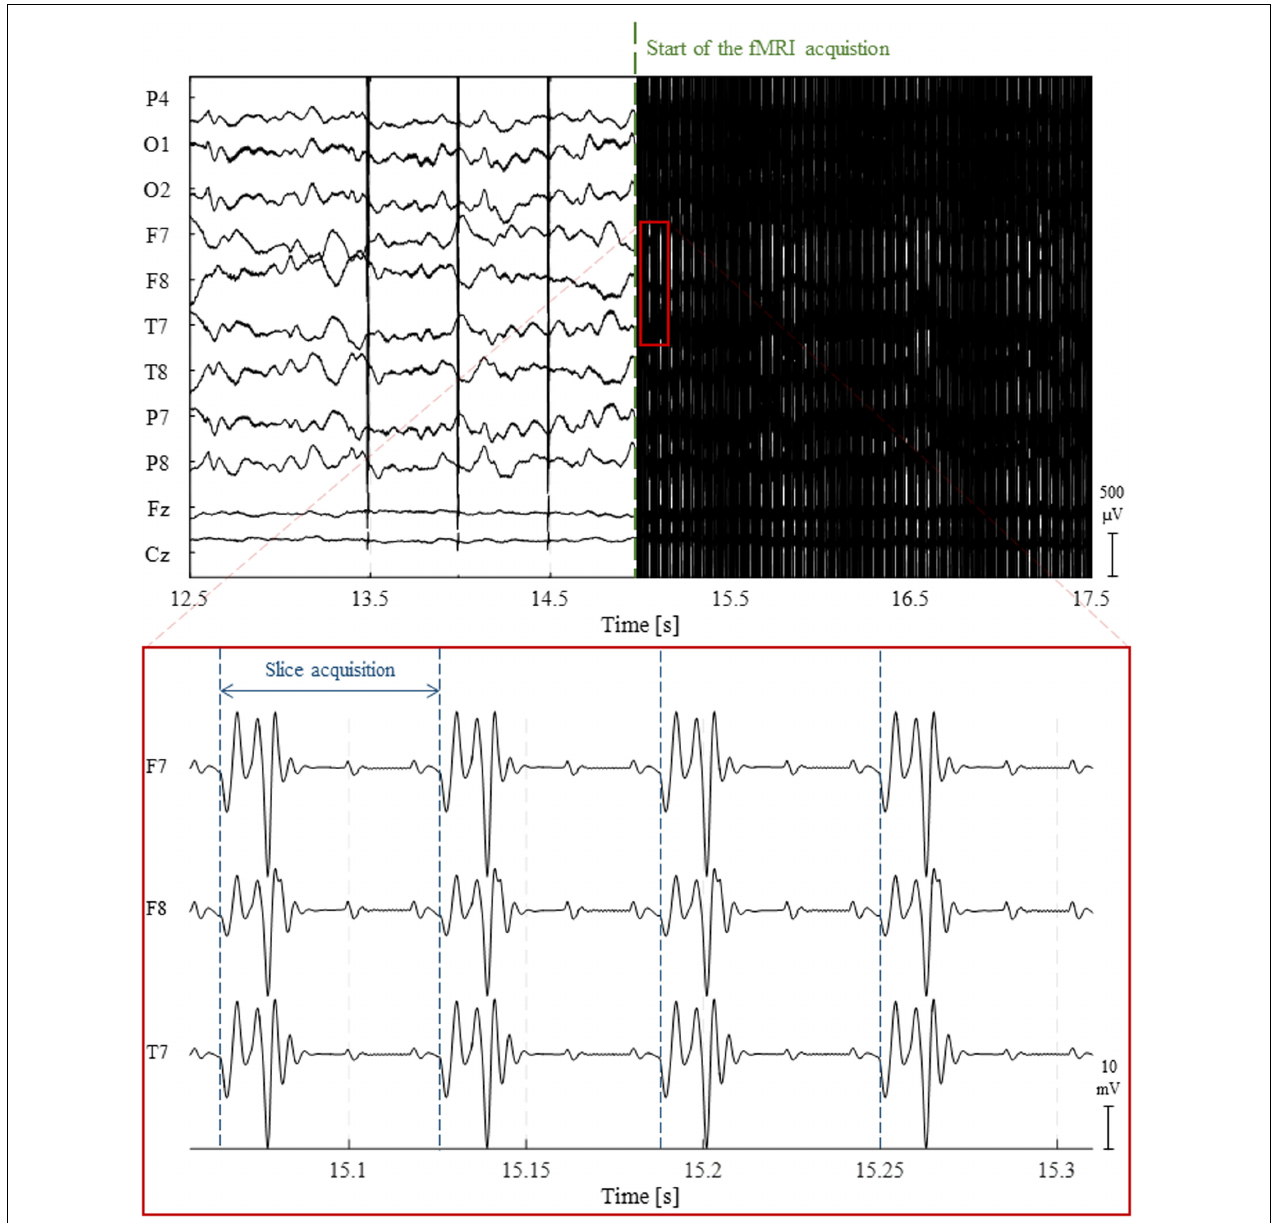
FIGURE 2 | Illustration of the gradient artifact (GA) generated by a 2D multi-slice EPI sequence. (Top) 5 s traces of raw EEG data from 10 channels. At approximately 15 s, the fMRI acquisition starts, completely obscuring any neuronal activity being recorded. (Bottom) The zoomed red box shows the high-amplitude electrical potentials generated by the time-varying gradients applied during the acquisition of four image slices using 2D multi-slice EPI; due to their clear periodicity and precise timing, these artifacts can be accurately corrected using channel-specific average template subtraction